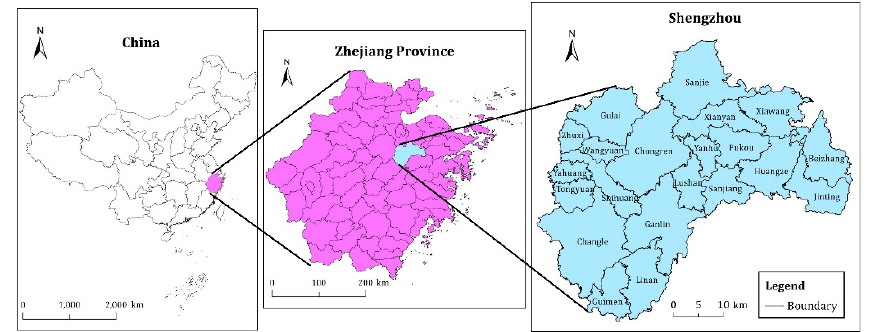
Figure 1. Location of the study area.